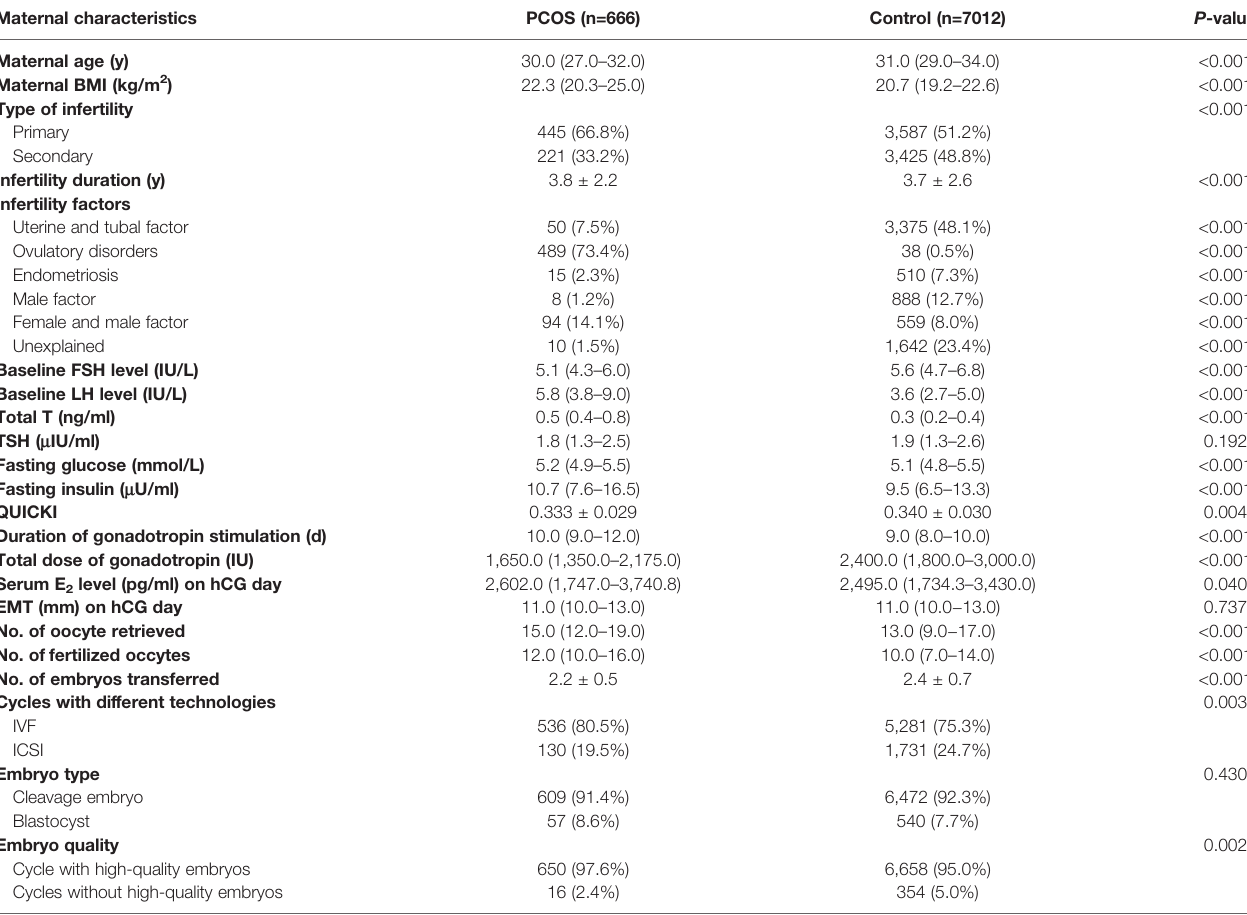
TABLE 1 | Clinical characteristics of women with polycystic ovary syndrome (PCOS) and controls during their fi rst IVF treatment cycle. Maternal